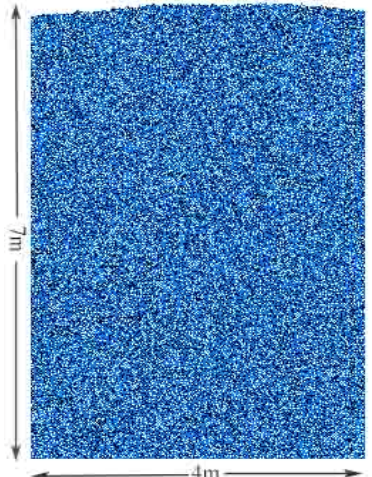
Figure 3. Soil particles.